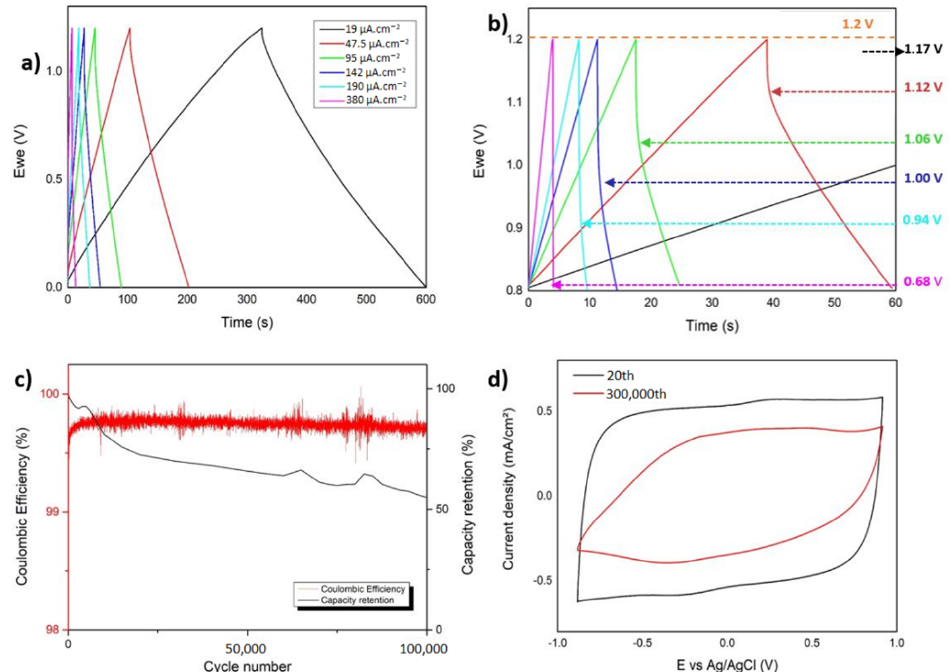
Figure 4. ( a ) Galvanostatic charge/discharge of the symmetric cell of Al 3 @SiNWs-PEDOT-OH elec- trodes. ( b ) Ohmic drop effect during galvanostatic charge/discharge. ( c ) Electrochemical cyclability of Al 3 @SiNWs-PEDOT-OH in aqueous media and ( d ) CV cyclability comparison between 20th and 100,000th cycle.